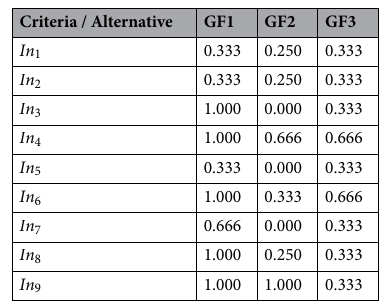
Table 3. Decision Matrix.